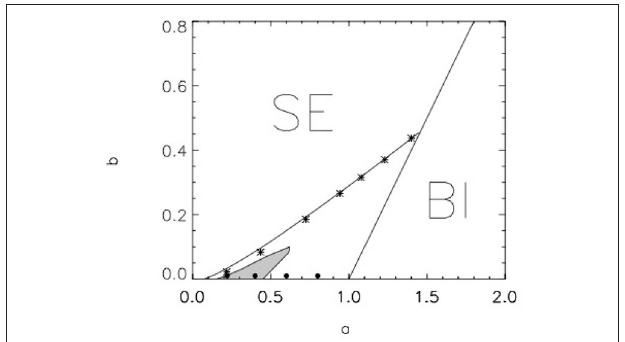
FIGURE 1 | Parameter space of the modified Barkley model with ǫ = 0.01 and k ǫ = 2. Within the SE region wave segments created in two dimensional medium are shrinking. Within the BI region the system (1)–(3) exhibits the bistability. Rotating spiral waves are analyzed between these two regions. Within the white domain spiral waves rotates around a circular core, while they are meandering within the light gray domain. Black spots correspond to parameter values used in Figure 2 .